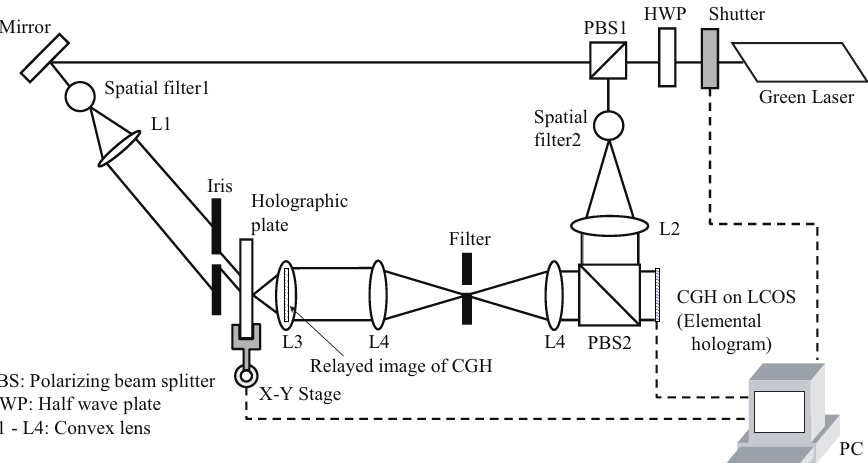
Figure 1. Basic configuration of a volume hologram